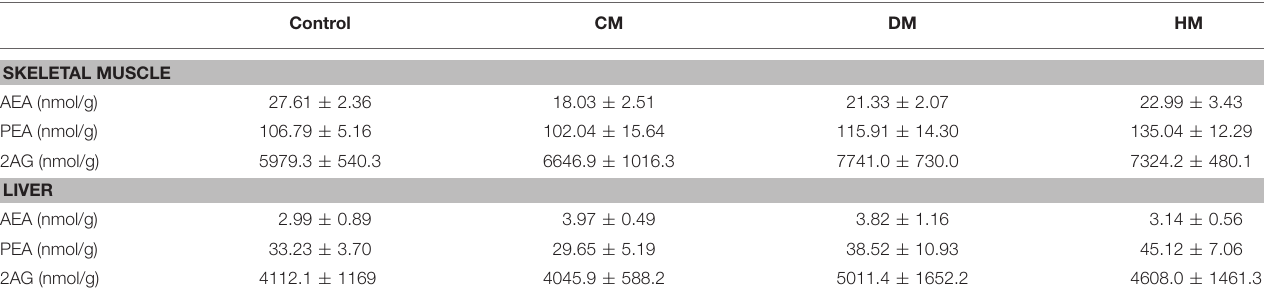
TABLE 3 | Tissue levels of AEA, PEA, and